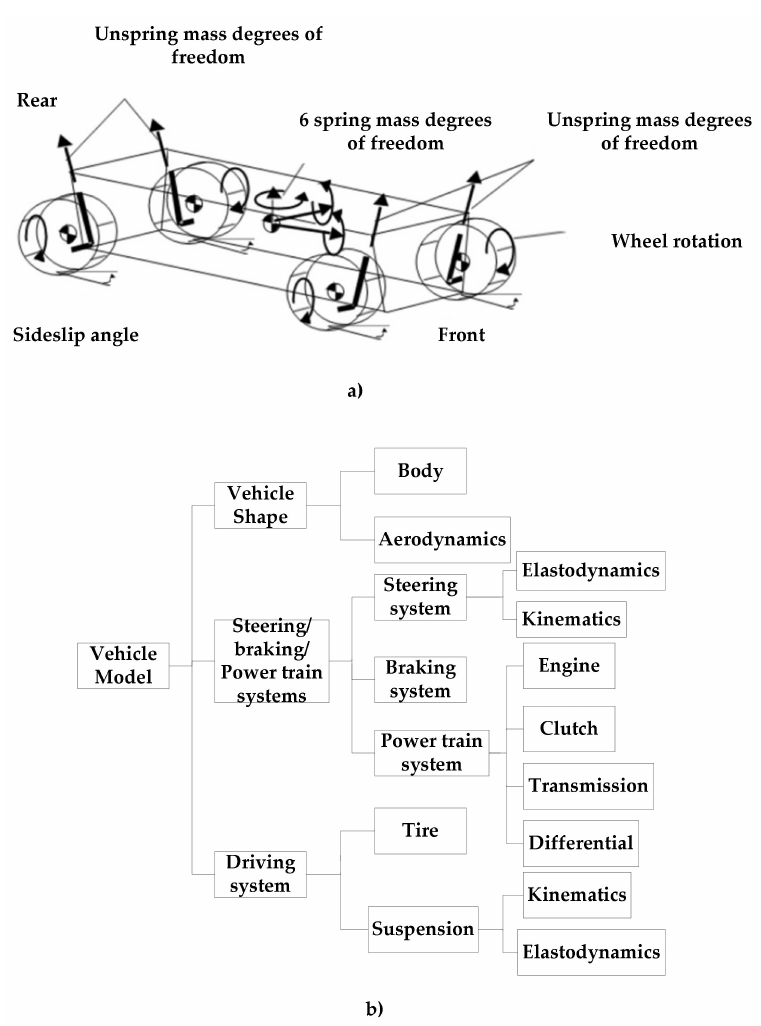
Table 1. Simulation Parameters of SUV used in this study.